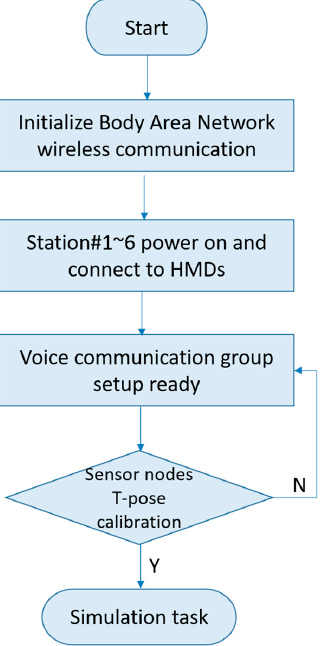
Figure 13. System initialization flow diagram.